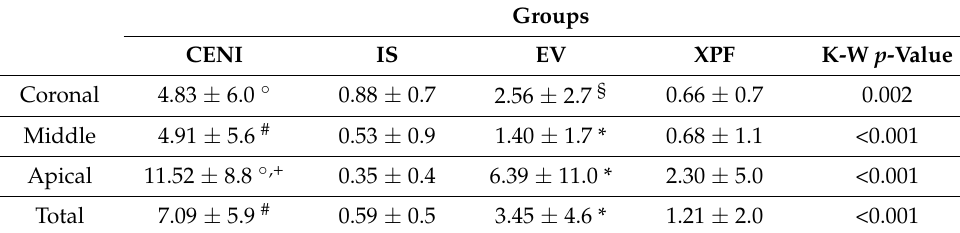
Table 1. Calcium hydroxide residues % (mean ± SD) inside the root canal measured on SEM images.